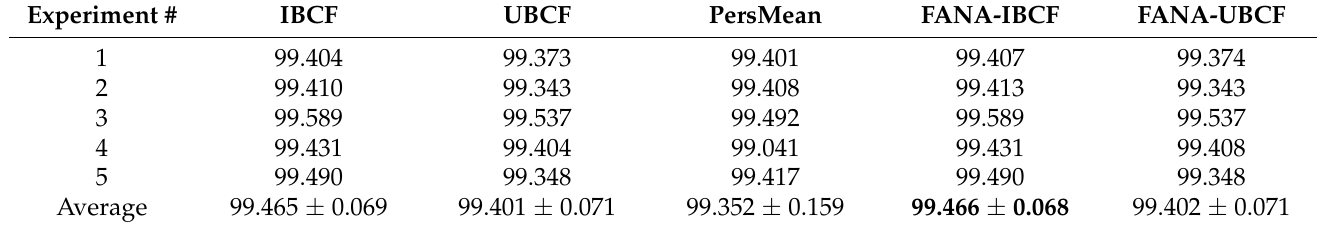
Table 7. Comparison of normalized discounted cumulative gain (nDCG) performance among IBCF, UBCF, PersMean, and our proposed approach, FANA-CF, using 5-fold cross validation. We have calculated the average of nDCG values and the standard deviation for each approach.